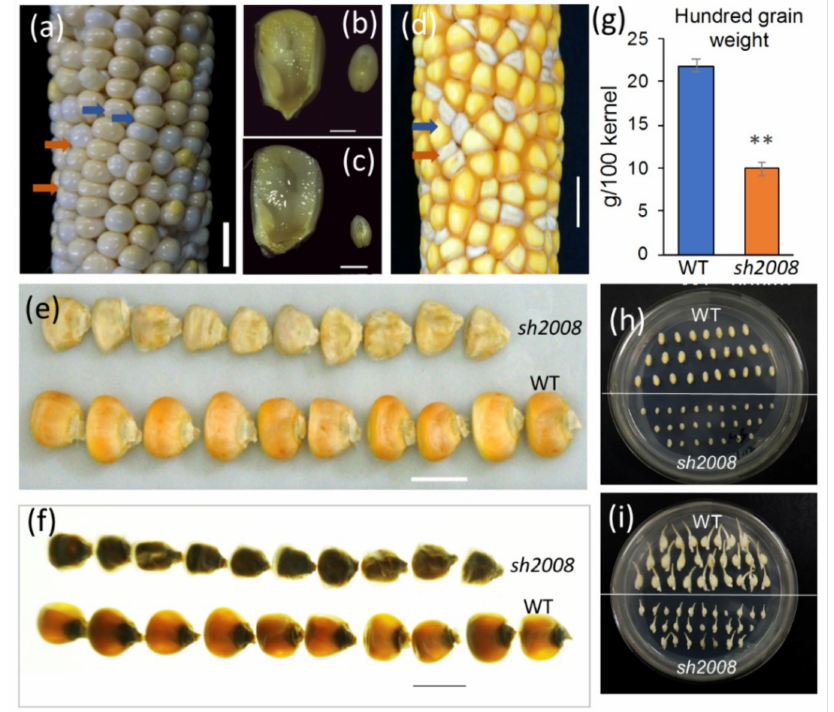
Figure 1. Kernel phenotype of the sh2008 mutant and WT. ( a ) The F2 ears at 14 DAP. Blue arrows indicate the normal kernels, which the content from fluid to milky white fluid, while the mutants (orange arrows) are still blisters and contain clear fluid. ( b , c ) Longitudinal section of immature WT ( b ) and sh2008 ( c ) kernels at 14 DAP to show the content in the kernels of the mutant and WT. ( d ) The morphology of the mature heterozygous ears. Blue and orange arrows in panel ( d ) and bars in panel ( e ) indicate the WT and the sh2008 mutant kernels. ( e , f ) The kernels from a heterozygous ear under natural light ( e ) and a lightbox ( f ) showing the opaque phenotype of the kernels from the sh2008 mutant (upper) and normal control (WT, lower). ( g ) Kernel weight of the sh2008 and WT. Values are the means of the three replicates ± SD. ** denotes statistical significance with p < 0.01 by using a t -test. ( h , i ) Germination assay of the immature embryos from the WT and sh2008 mutant on 1/2 MS medium for 0 ( h ) and 6 days ( i ) showing that embryo germination was not affected in the mutant, but the development of mutant embryos was later than the WT. Scale bar, 1